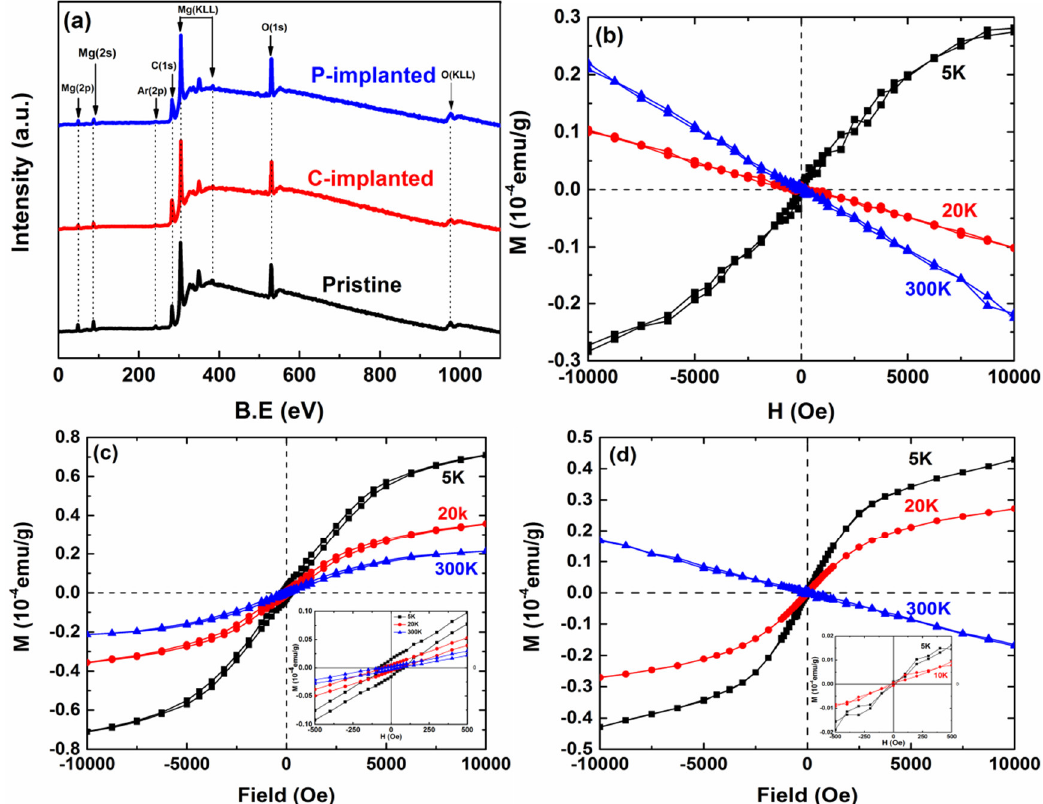
Figure 1. ( a ) Full XPS spectrum of pristine and implanted samples. M-H plots for ( b ) pristine ( c ) C-implanted ( d ) P-implanted MgO samples.